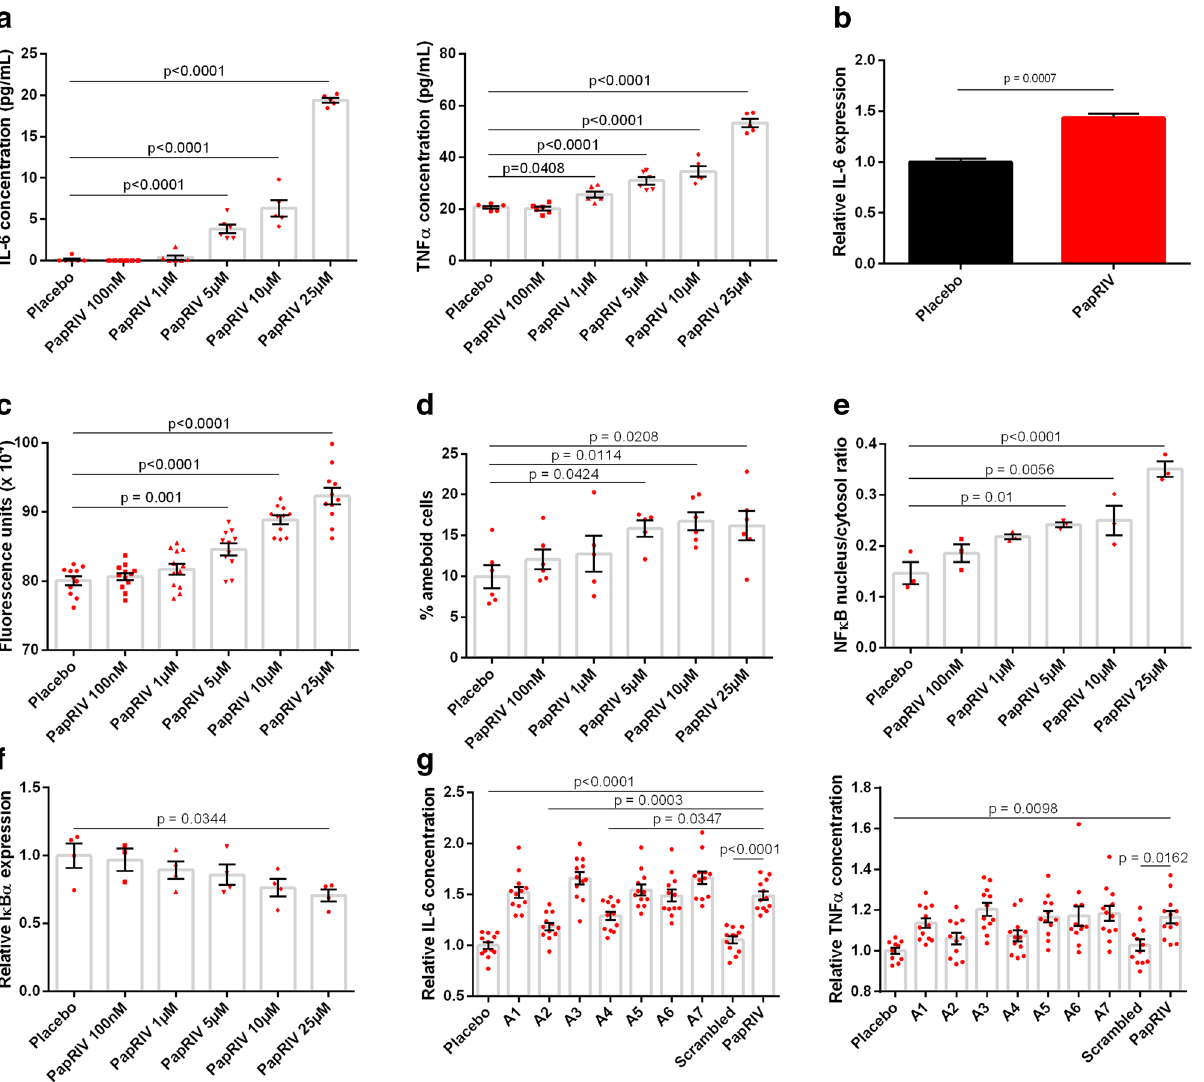
Figure 2. In vitro microglial activation of BV-2 cells by PapRIV. ( a ) IL-6 and TNFα levels increase after increasing concentrations of PapRIV (n = 6). ( b ) IL-6 mRNA expression is increased after treatment with 10 µM PapRIV (n = 6). (Mann–Whitney U test) ( c ) Reactive oxygen species are formed after treatment (n = 12). ( d ) The fraction of ameboid cells, a marker for microglial activation, increased after treatment (n = 6). ( e , f ) Activation is mediated by an increased nuclear translocation of NF-kB caused by decreasing IκBα levels (n = 3). ( g ) Critical amino acids are identified by an alanine scan of the native sequence (10 µM, n = 12). Mean ± SEM, One-way ANOVA, post-hoc